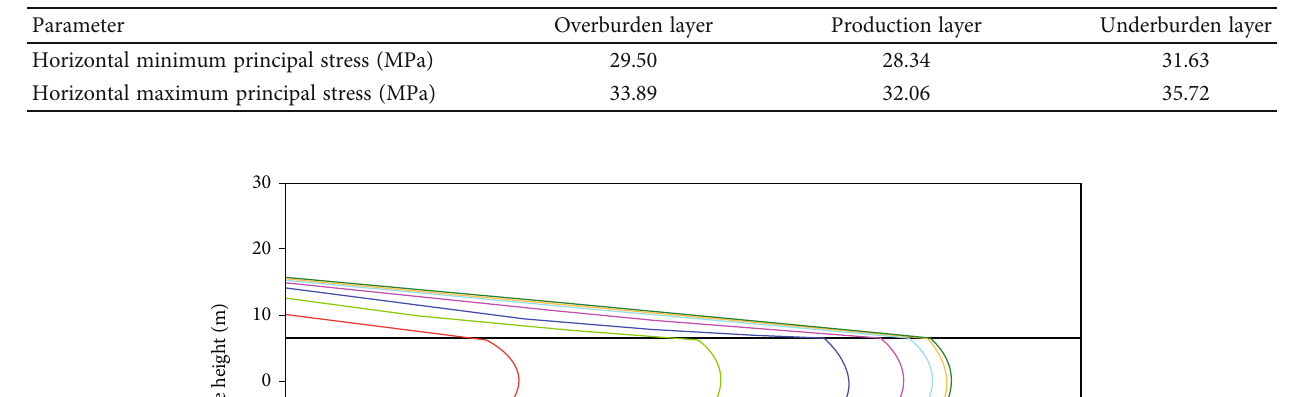
Table 3: Rock mechanics parameters.